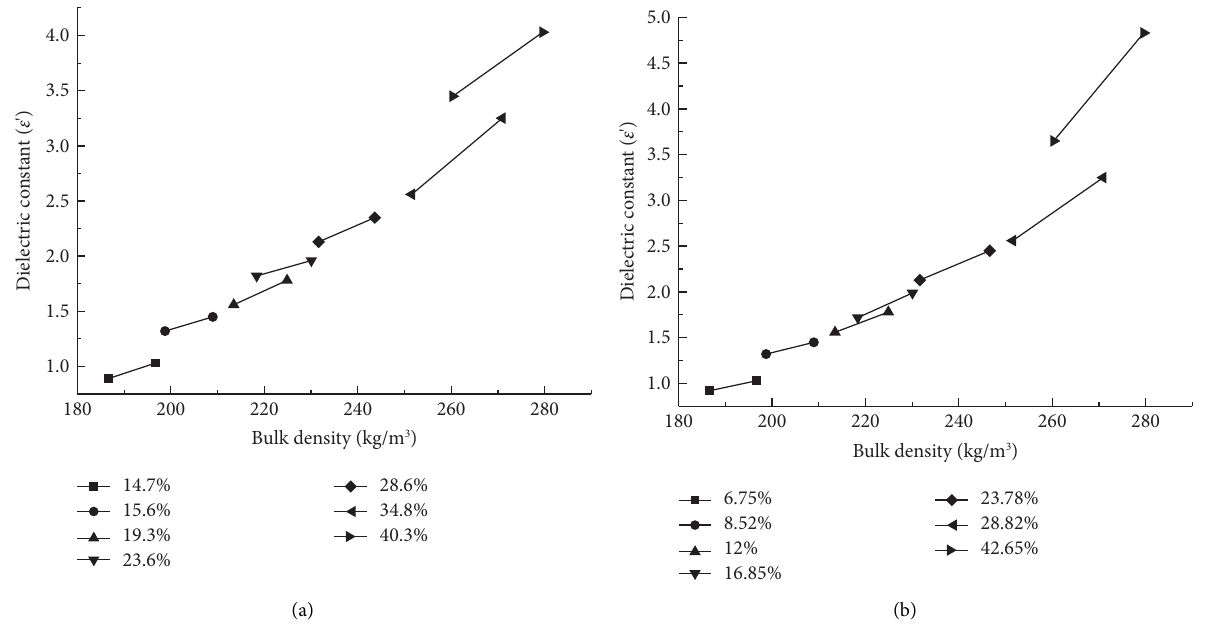
Figure 7: Efect of bulk density on the dielectric properties of peanut shells and kernels of diferent moisture contents. (a) Peanut shells. (b) Peanut